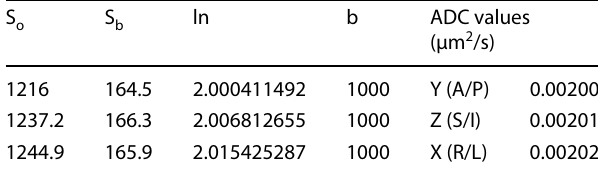
Table 5 The measured ADC values for 1.5 T